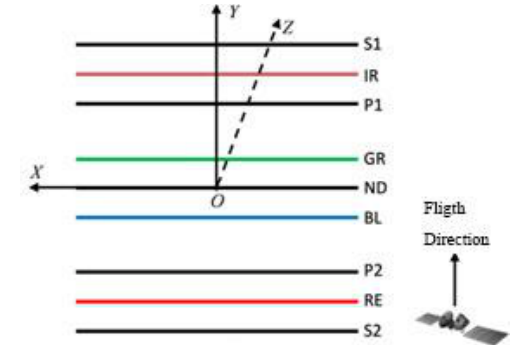
Figure 1. Linear array CCD arrangement of HRSC